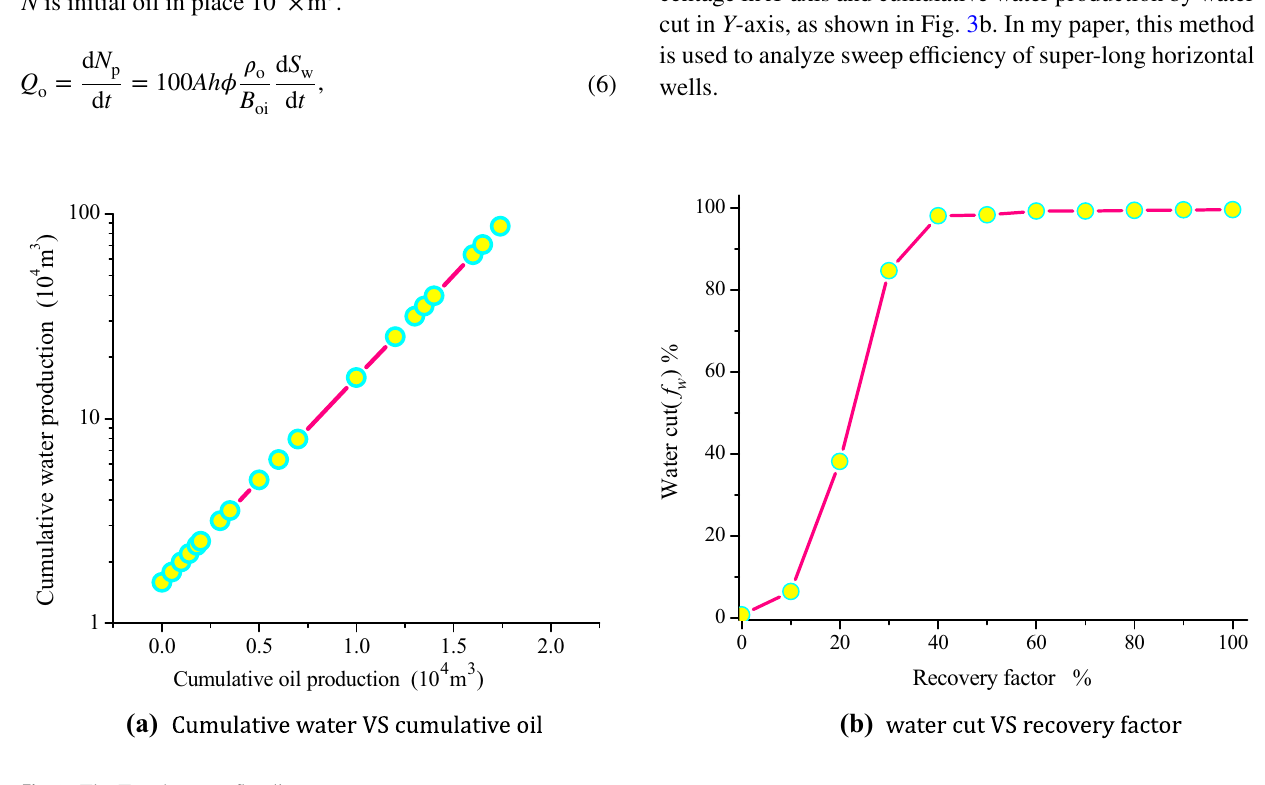
Fig. 3 The Tong’s water flooding